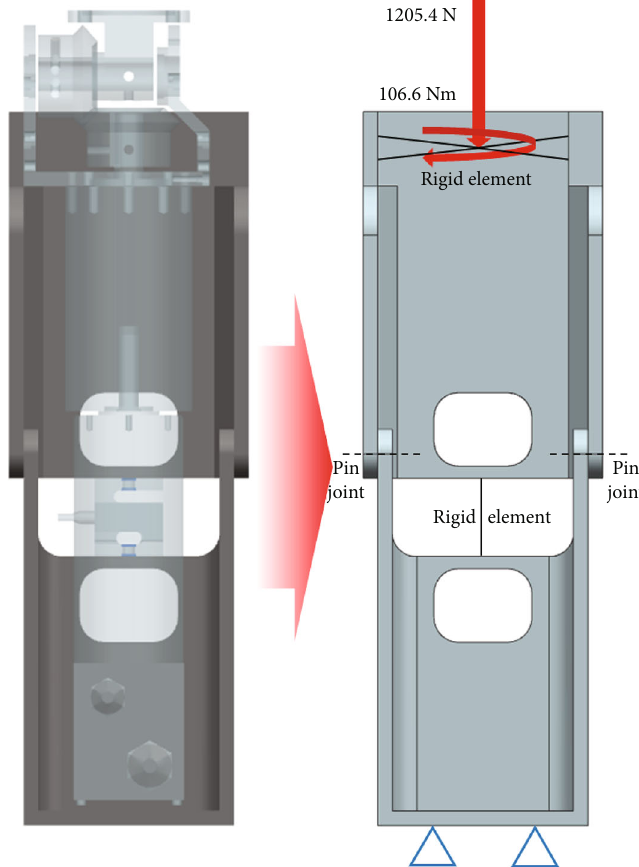
Figure 6: Boundary conditions for lower-limb